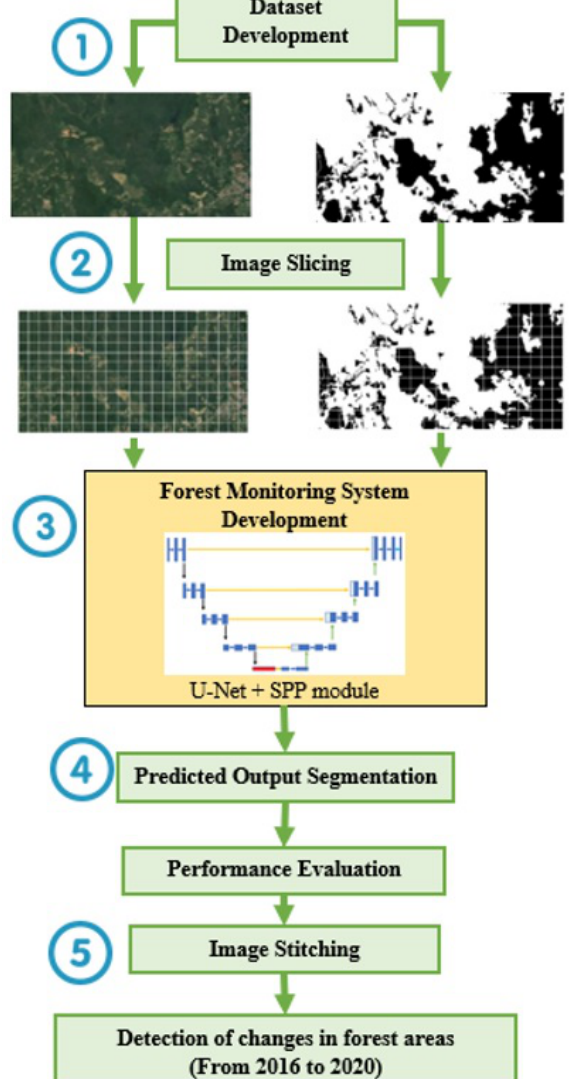
Figure 1. Workflow of the proposed automatic forest monitoring system